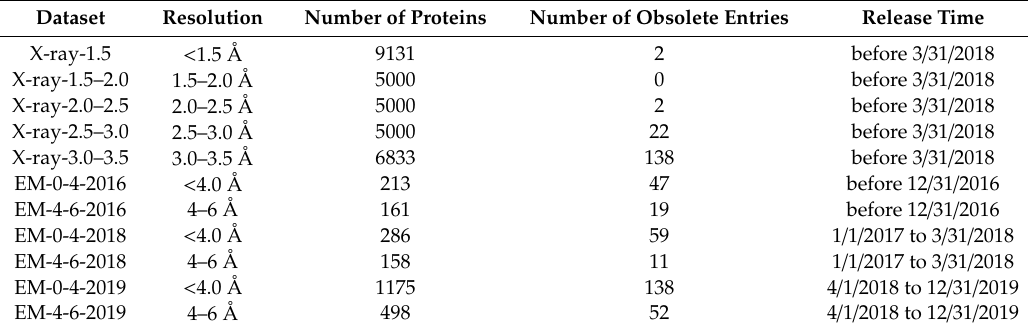
Table 1. Five X-ray atomic structures and six cryo-EM atomic structures used for HBOS profiles. The resolution ranges of X-ray data or cryo-EM density maps are included in the names of the datasets. The number of proteins in the dataset, the number of obsolete proteins as of 3 / 8 / 2020, and the release time of the structures are indicated in separate